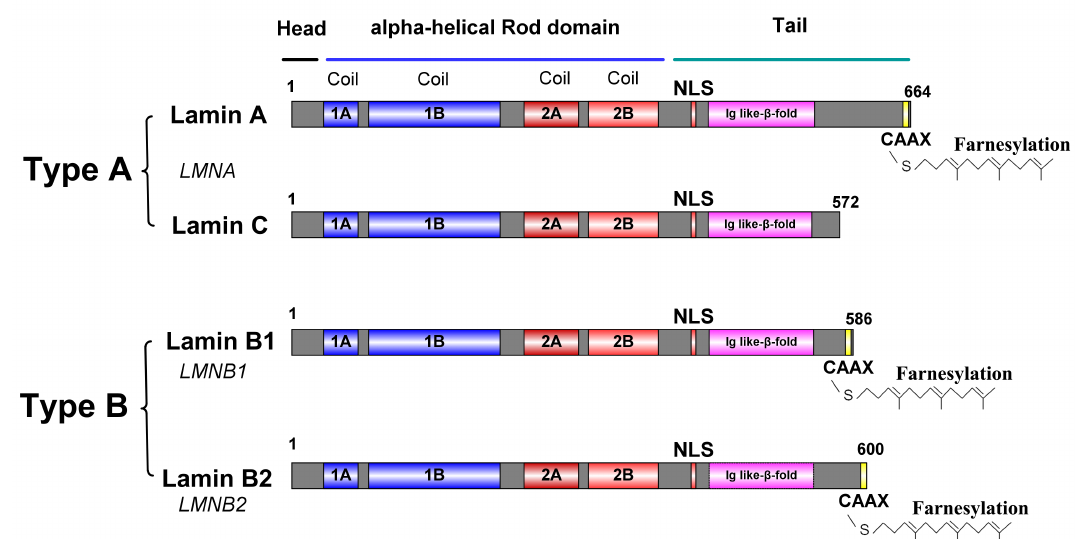
Figure 1. Schematic illustration of type A and B lamins. NLS, nuclear localization